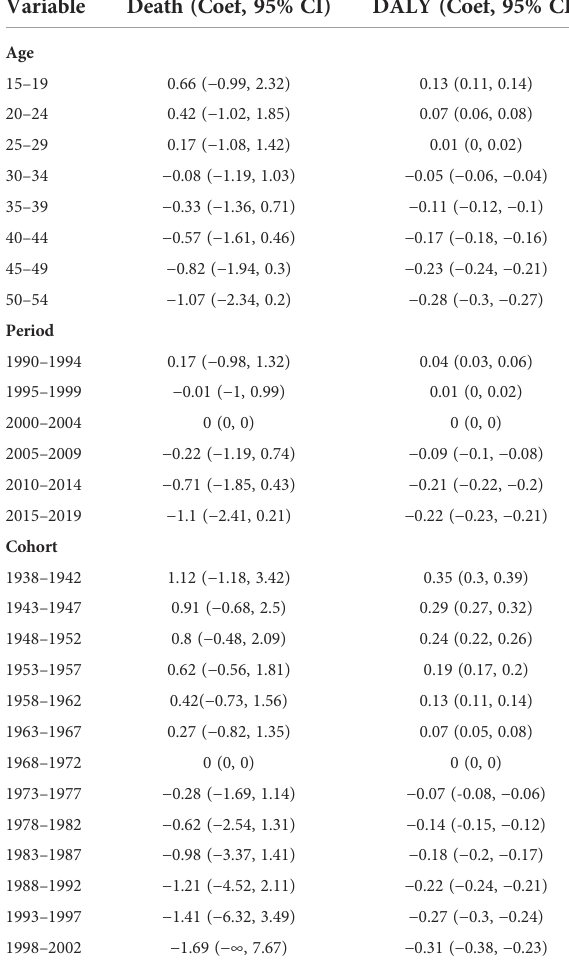
TABLE 4 Age – period – cohort (APC) model analysis results of endometriosis death and DALY rates in China.